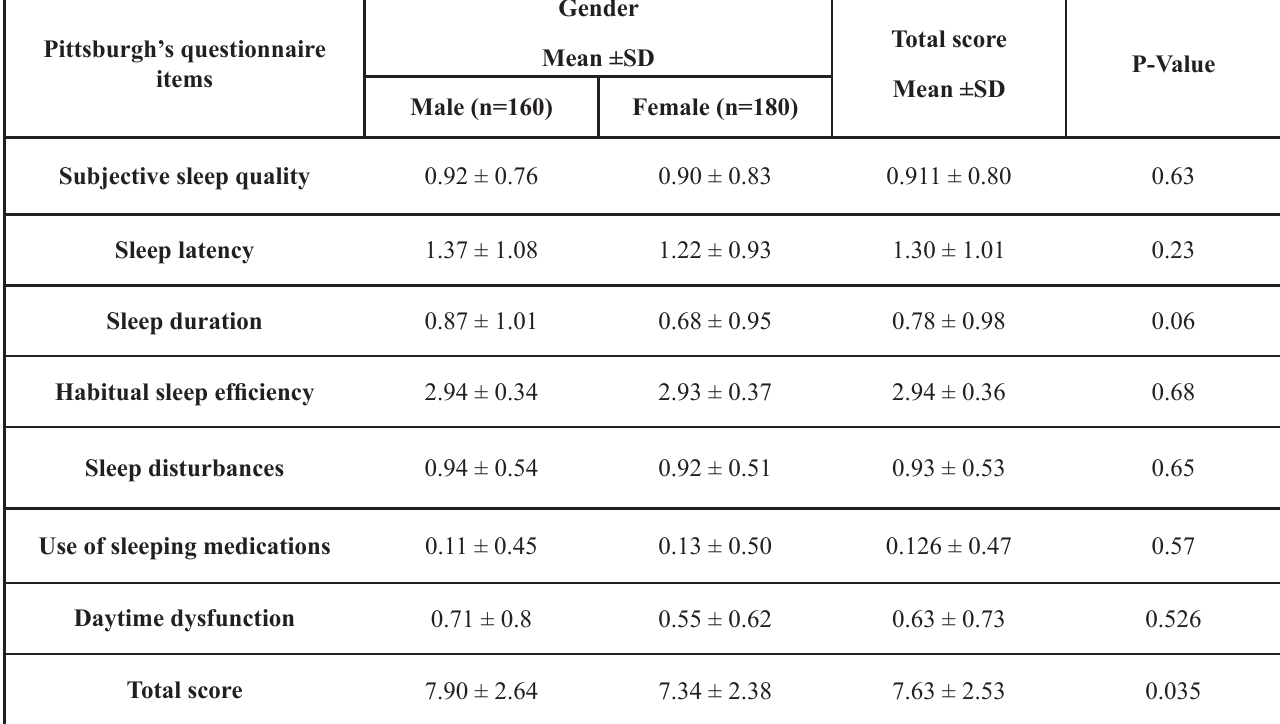
Table 2: Mean and standard deviation of total score and items of sleep quality questionnaire by gender of students participating in the study Pittsburgh’s questionnaire